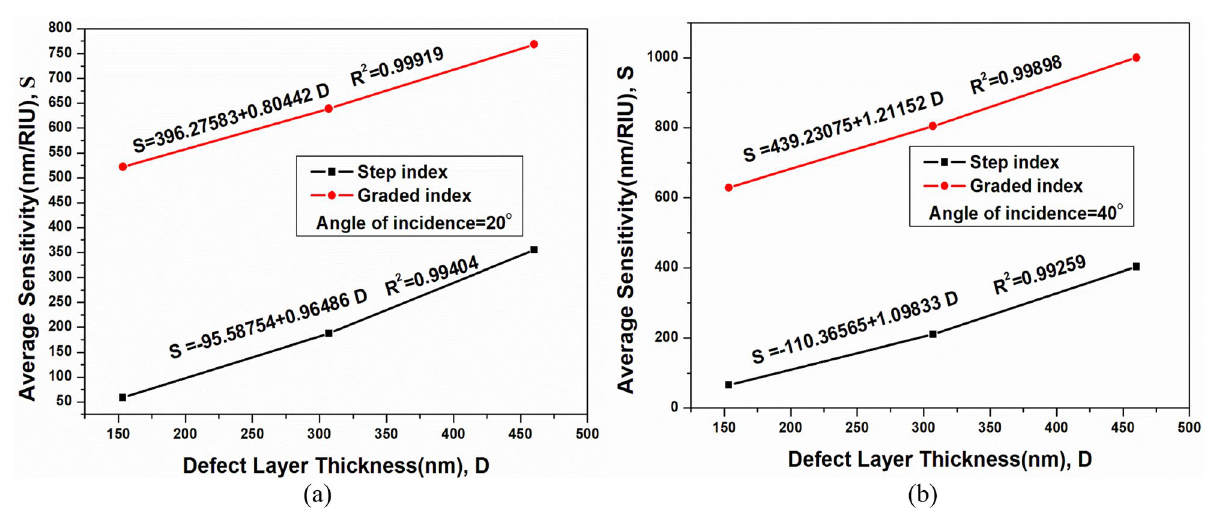
Figure 6. Sensitivity comparison of step index and graded index structure with different defect layer thickness with ( a )incidence angle = 20° ( b ) incidence angle =